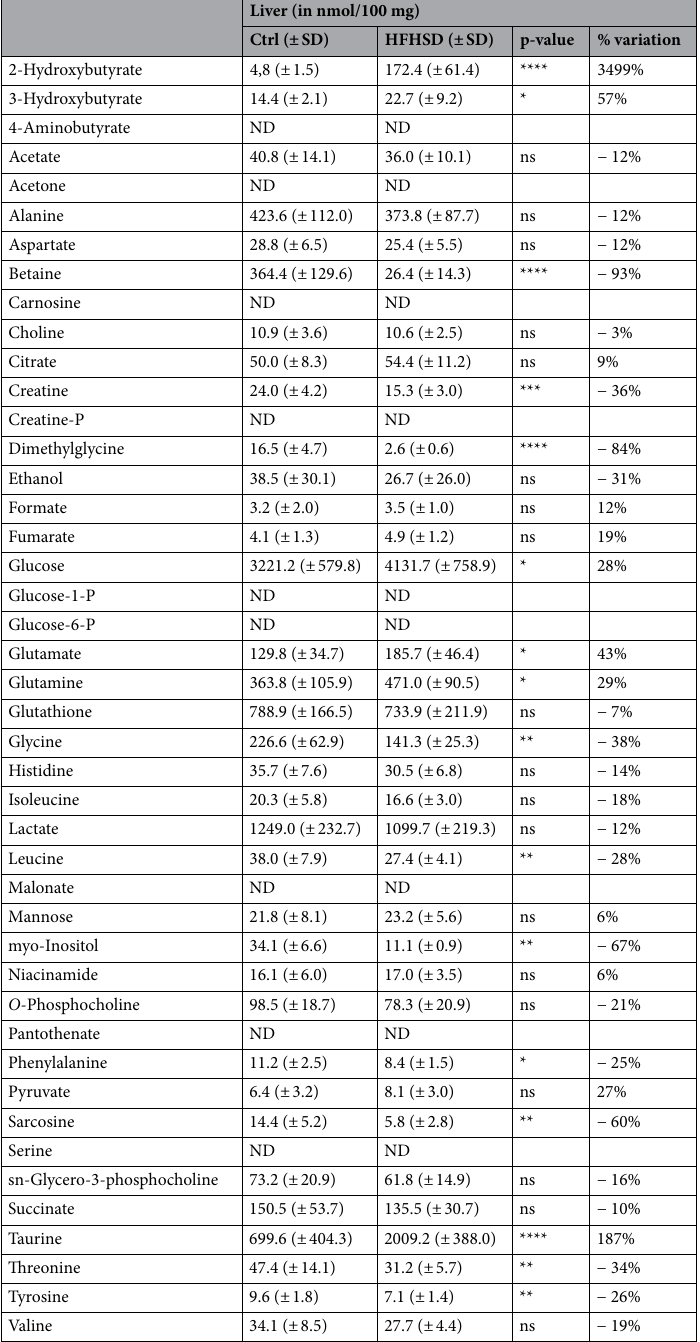
Table 4. Metabolite concentrations measured by NMR in the liver of SD and HFHSD mice. Results are expressed as mean ± standard deviation (SD) and are in nmol/100 mg of liver. Data are mean of n = 8 mice per group; Results of unpaired two-tailed t-test are indicated as non-determined (ND), non-significant (NS), p < 0.05 (*), p < 0.01 (**), p < 0.001 (***) and p < 0.0001 (****). Percentages of variation between HFHSD and control fed mice are